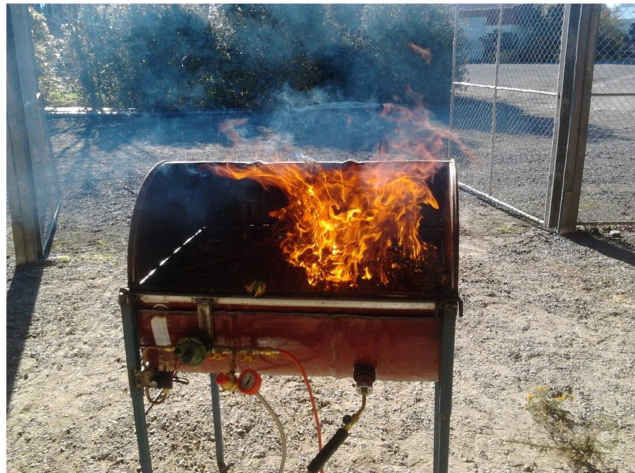
Figure 1. The device used for flammability measurements (Photo: T Curran).